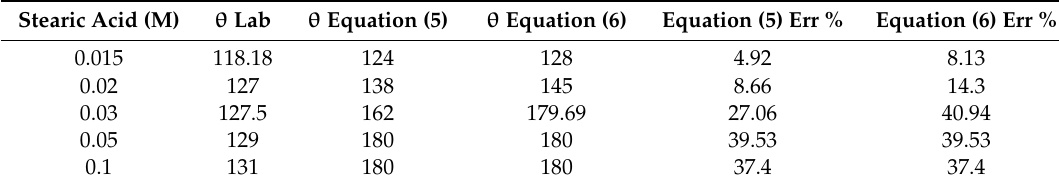
Table 2. Comparison of measured contact angle in the lab and calculated contact angle from Equations (5) and (6).